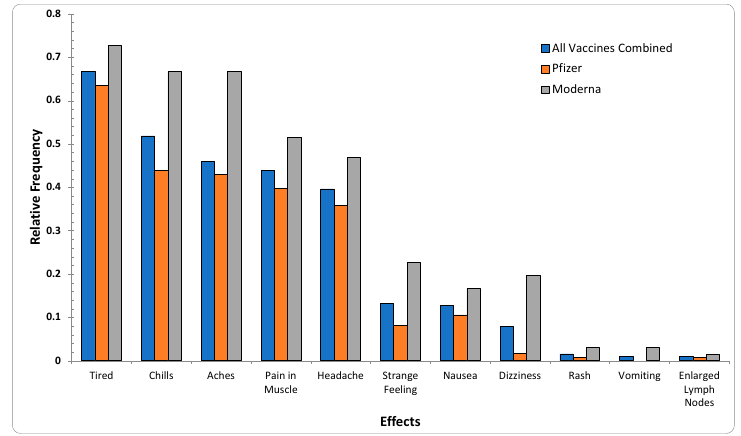
Figure 3. Relative frequencies of the 11 AEs appearing in survey data reports for all age groups per the two vaccine producers (Pfizer-BioNTech, Moderna). The subset { headache , chills , dizziness , nausea , itchy skin / rash , vomiting } was the same as 6 of the 20 most-reported effects in VAERS reports. 2.1. Associations of the Most Commonly Reported AEs via ARM and SOM The interrelationships of AEs from VAERS reports were analyzed via ARM and SOM with respect to two major age groups [<16, ≥ 16]. Assessment of the interrelationships of AEs for children revealed 16 non-redundant association rules (ARs) (Table 3). From a subset of one-to-one rules, the existence of Hyperhidrosis or flushing was shown to imply the existence of dizziness with lift-over 3 ( R 2,10 ). Chest pain was found to be prominent with dependency over the subset { Electrocardiogram ST segment elevation , Chest X-ray normal , Echocardiogram normal , Myocarditis , Electrocardiogram normal , C-reactive protein increased , Troponin increased } with a lift value of >8 ( R 3,5,7–9,11,13 ). Additionally, it was also noticed that hyperhidrosis was associated with flushing with a high lift value of 18.8 ( R 9 ). Although fatigue appeared among the top 6 AEs for children based on its individual frequency, its correlation with any other AE could not qualify it for the top 14 ARs (Table 3 and Figure 1). Table 3. Non-redundant association rules for post-COVID-19 vaccine AEs reported in VAERS reports for children based on cleaned with duplicate rows merged. Rule 14 was the only non-redundant many-to-one rule identified for children. The highlighted regions in gray represent a subset of rules with relatively high counts in the dataset (>200) and include { dizziness , hyperhidrosis , syncope , unresponsive to stimuli , pyrexia , chills , myocarditis }, which were also among the 20 most commonly reported AEs in children when explored based on their individual